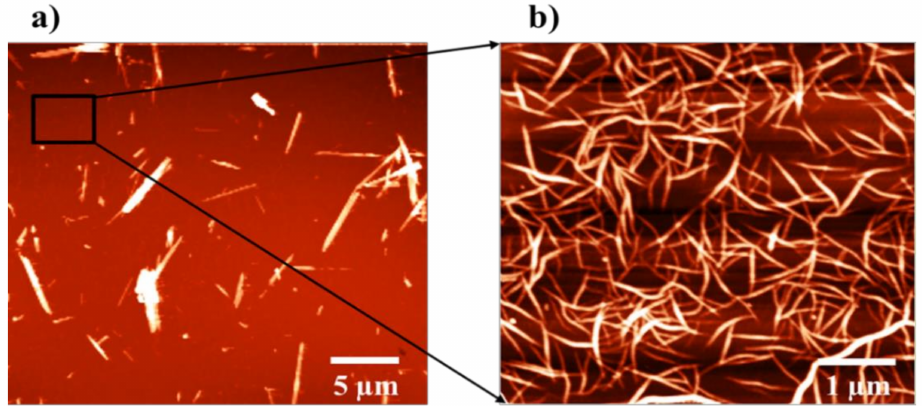
Figure 2. ( a ) AFM images of the CP6 film at 5 µ m; ( b ) at 1 µ m.